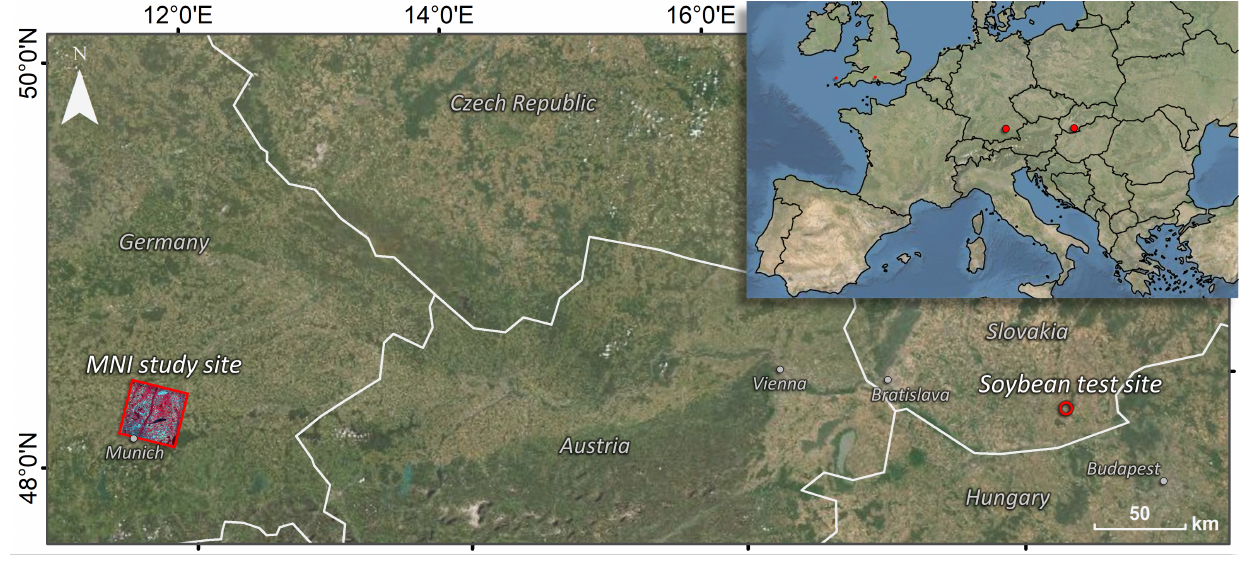
Figure 3. Location of the two study sites: PRISMA acquisition at MNI in Southern Germany and soybean sampling in Southern